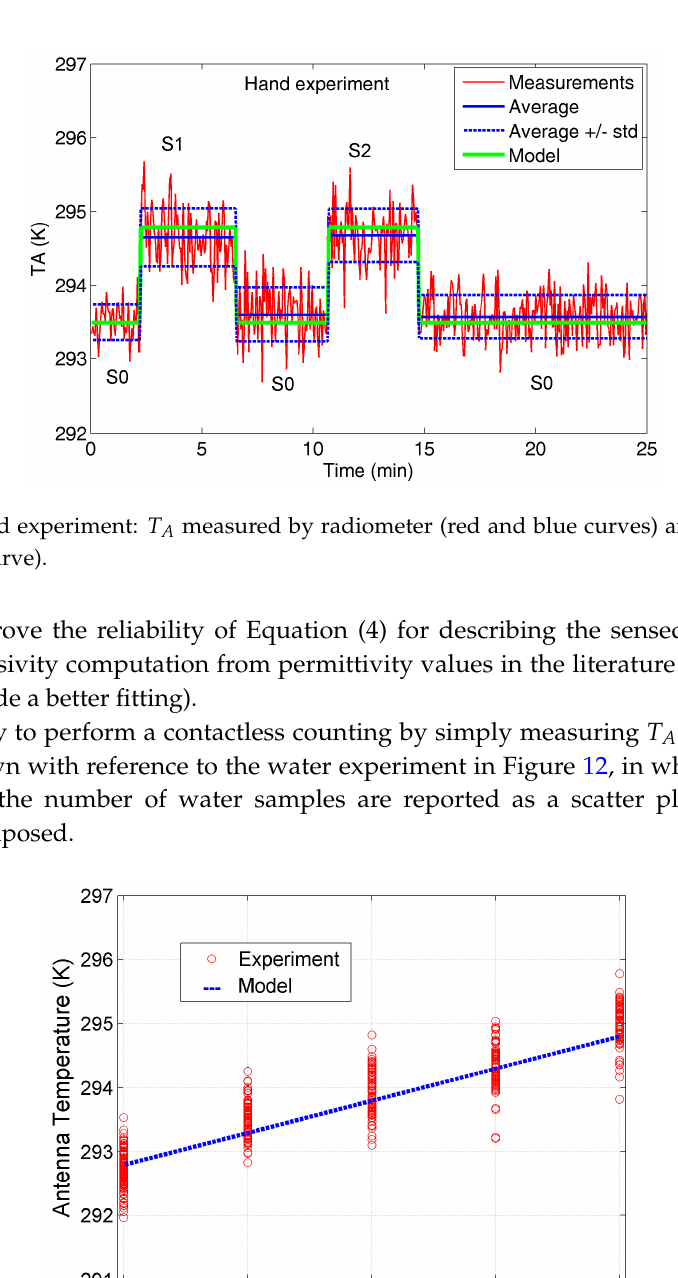
Figure 12. Water experiment: number of targets vs. T A measured by radiometer (red circles). In blue the T A estimated by model.